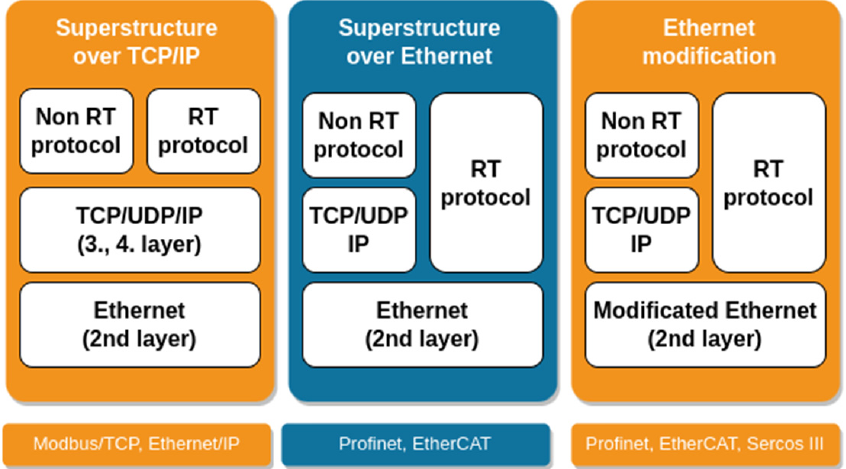
Figure 6. The implementation of modern industrial protocols in TCP/IP + Ethernet networks.